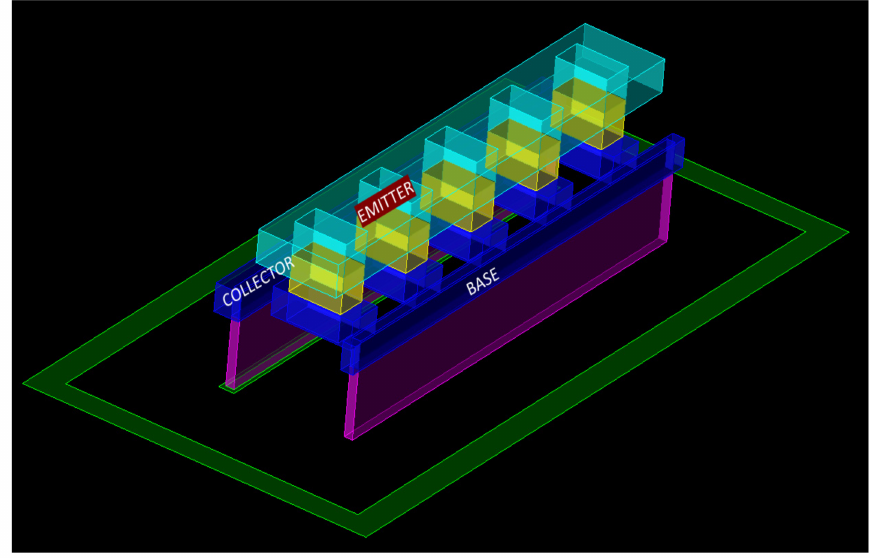
Figure 2. The 3D structure of the heterojunction bipolar transistor (HBT) transistor.